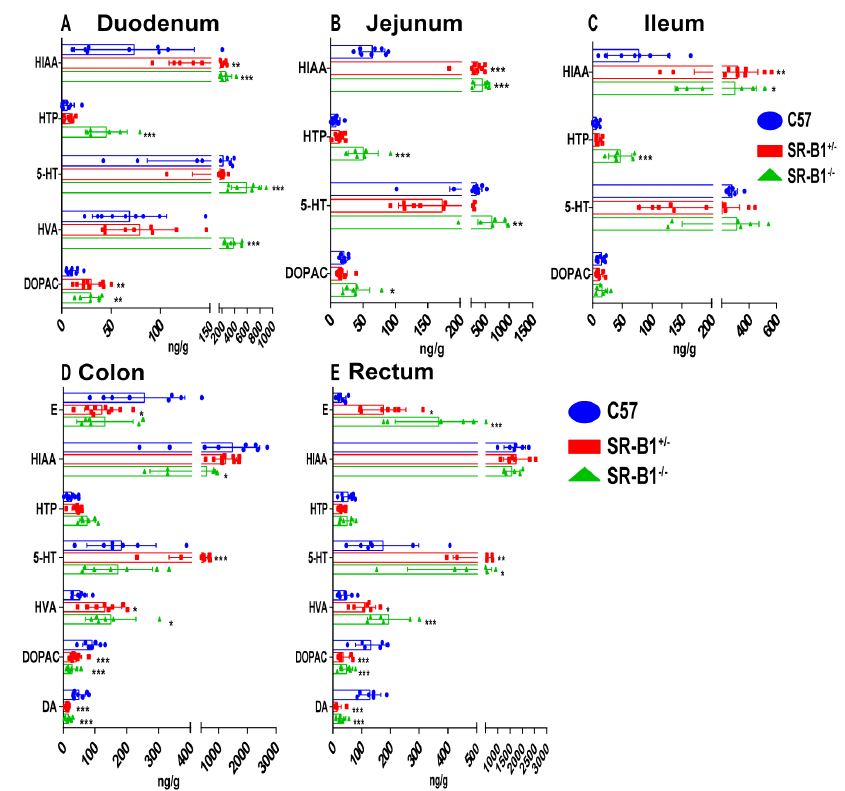
Figure 6. The difference in neurotransmitter contents among SR − B1 − / − , SR − B1 +/ − , and C57 mice ( n = 6–10). Determination of neurotransmitter contents in the duodenum ( A ), jejunum ( B ), ileum ( C ), colon ( D ), and rectum ( E ) of the C57, SR − B1 +/ − , and SR − B1 − / − mice. The data are presented as the means ± SD; * p < 0.05, ** p < 0.01, and *** p < 0.001 compared with the C57 mice. E (adrenaline), the